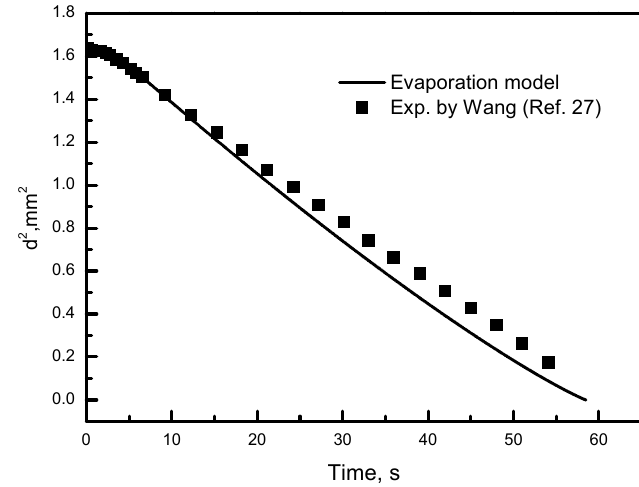
Figure 3. Numerical and experimental results of droplet evaporation.